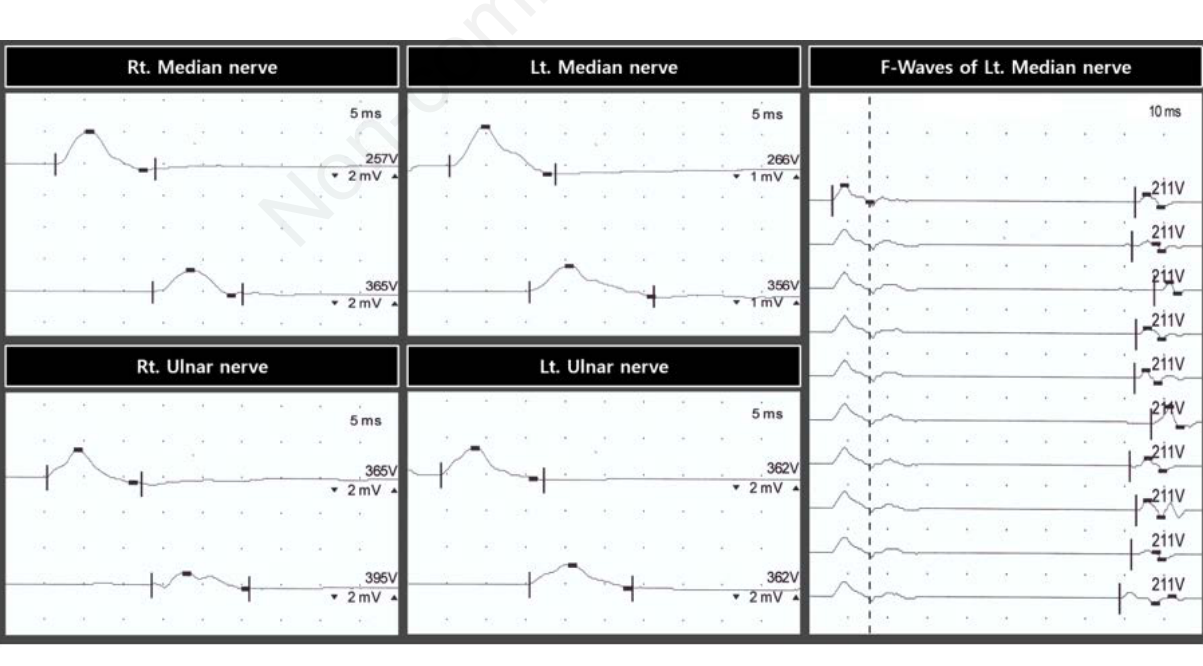
Figure 2. Median and ulnar motor nerve conduction responses at 10 months after onset showed delayed latency, decreased conduction velocity, and low amplitude of compound motor action potential. In addition, F wave on the left median nerve showed delayed